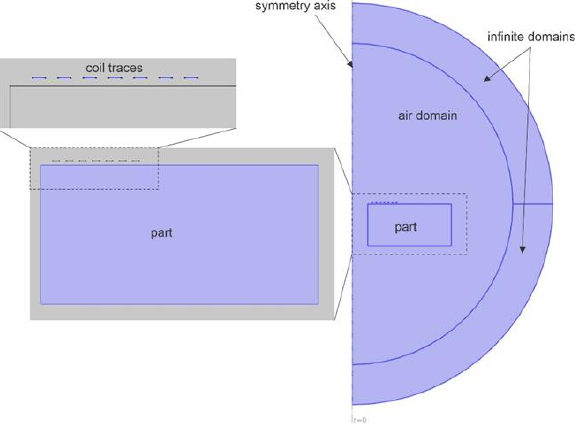
Figure 5. Geometry of the simulated 2D axisymmetric problem representing the part and the coil. The complete mesh contained approximately 2000 domains and 150 boundary ele- ments. The maximum element size of the boundary domain represented by the coil trace was half of its width, i.e., 150 μ m. Moreover, the side of the part facing the coil was meshed using closely spaced twelve boundary layers to better represent the region of interest. The mesh of the geometry is shown in Figure 6.